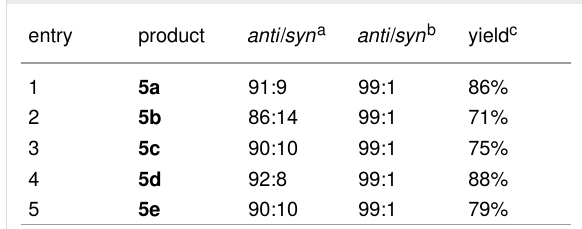
Table 1: Optimization of reaction